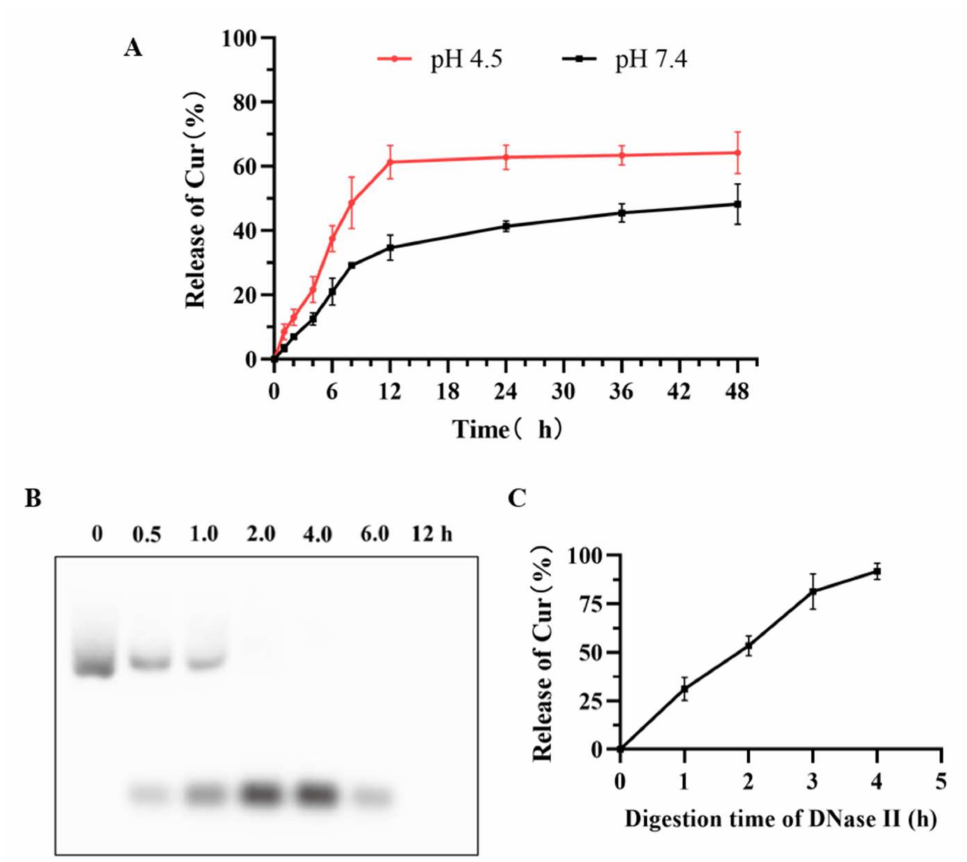
Figure 5. ( A ) Cur release profile of Cur@affi-F/GQs in PBS (pH 7.4) and acetate buffer (pH 4.5). ( B ) FUdR release behavior in DNase II solution. ( C ) Cur release profile in DNase II